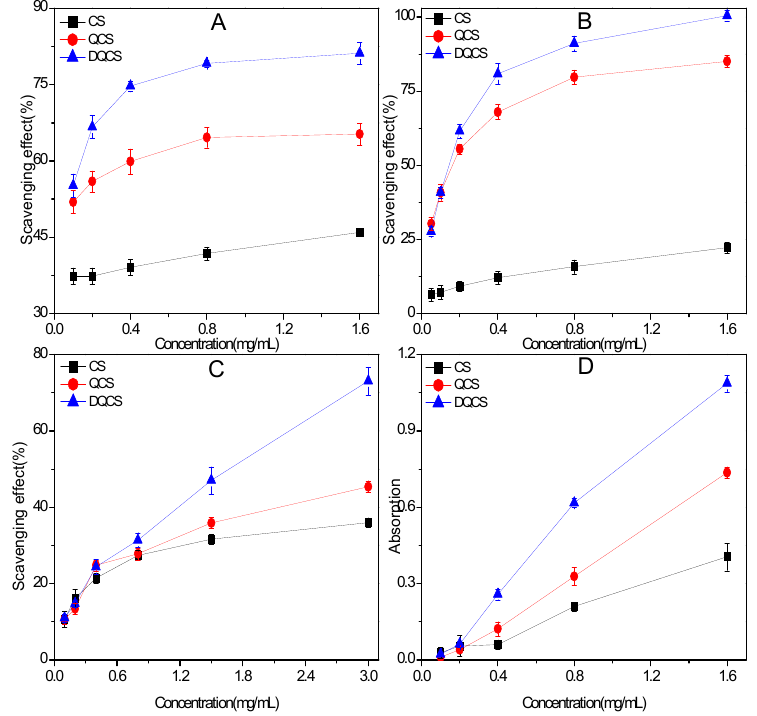
Figure 5. Antioxidant effect of samples: ( A ) DPPH-radical scavenging ability; ( B ) Hydroxyl-radical scavenging ability; ( C ) Superoxide-radical scavenging ability; ( D ) Reducing power.